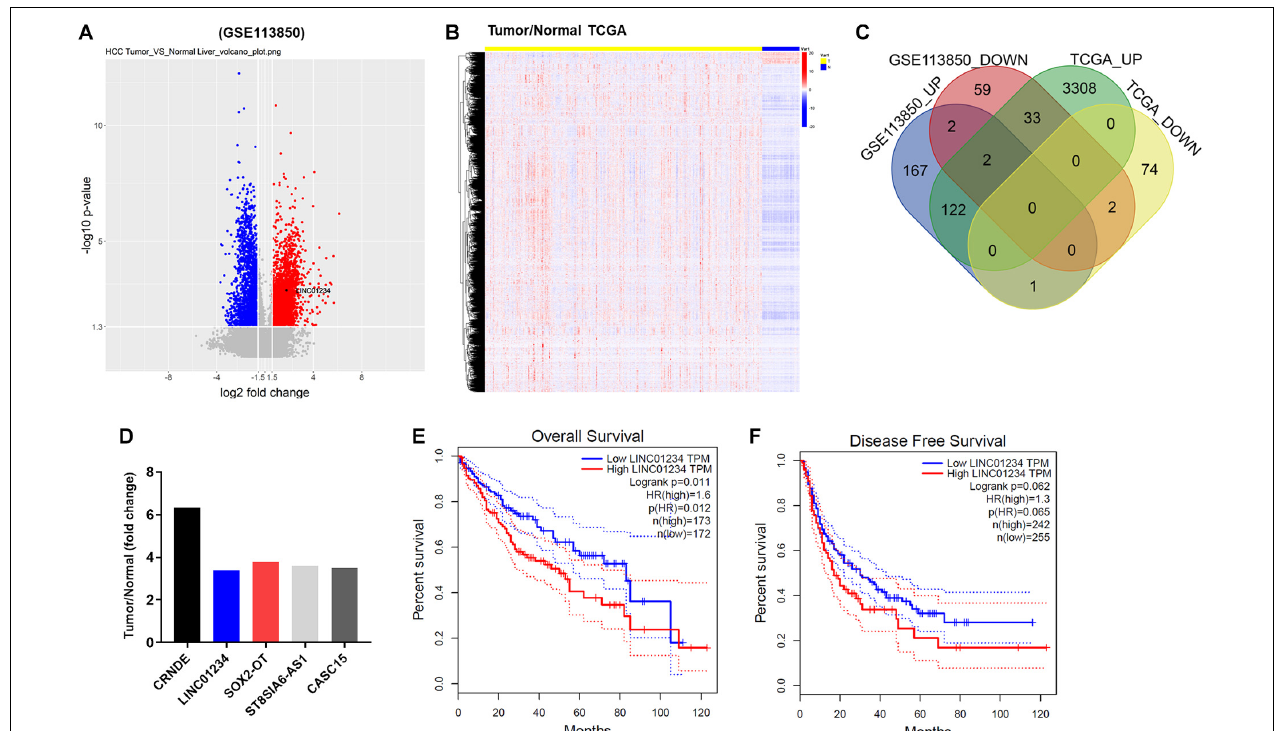
FIGURE 1 | The differentially expressed lncRNAs between liver cancer and adjacent normal tissues. (A) Volcano plots illustrating the lncRNAs differentially expressed in liver cancer detected in the GSE113850 dataset. Red indicates a higher expression level, while blue indicates a lower expression level. (B) Differentially expressed lncRNAs among normal and liver cancer tissues were presented by TCGA. (C) Venn diagram showing the overlap among the differentially expressed lncRNAs in the GSE113850 dataset. (D) Dataset indicated overlap 5 upregulated lncRNAs in liver cancer tissues. (E,F) Overall and disease free survival of liver cancer were analyzed by